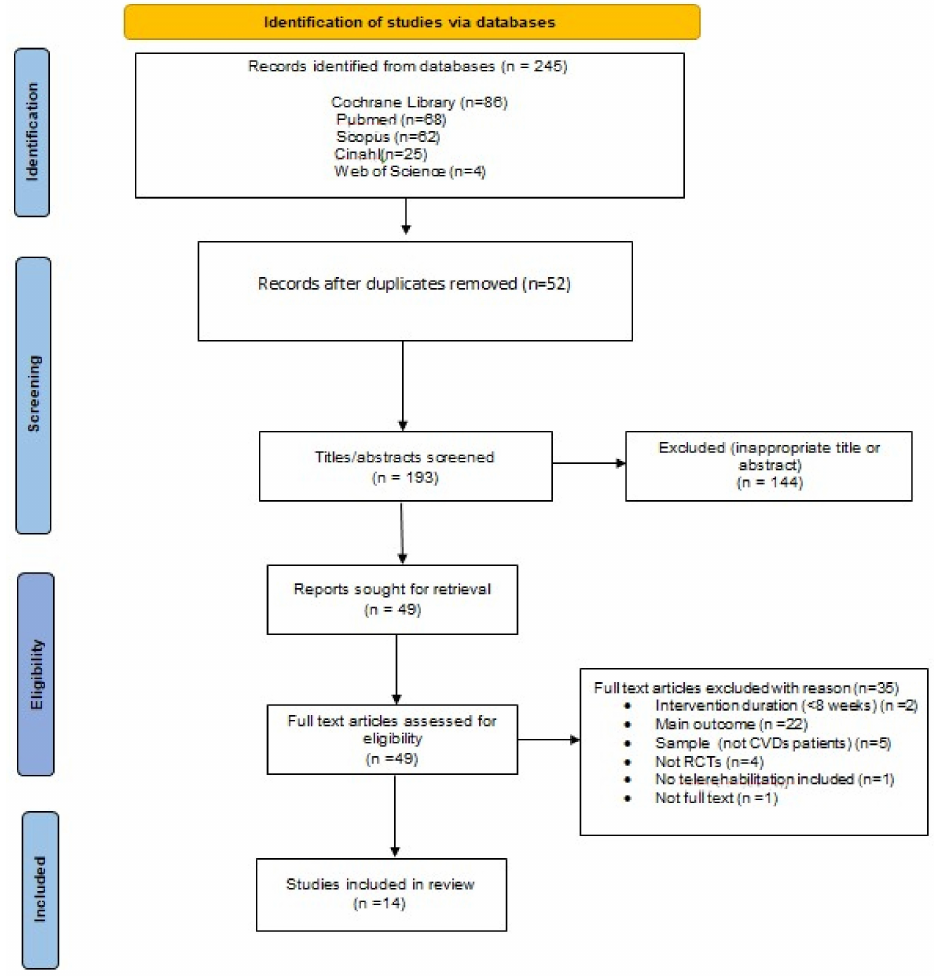
Figure 1. Flowchart of the